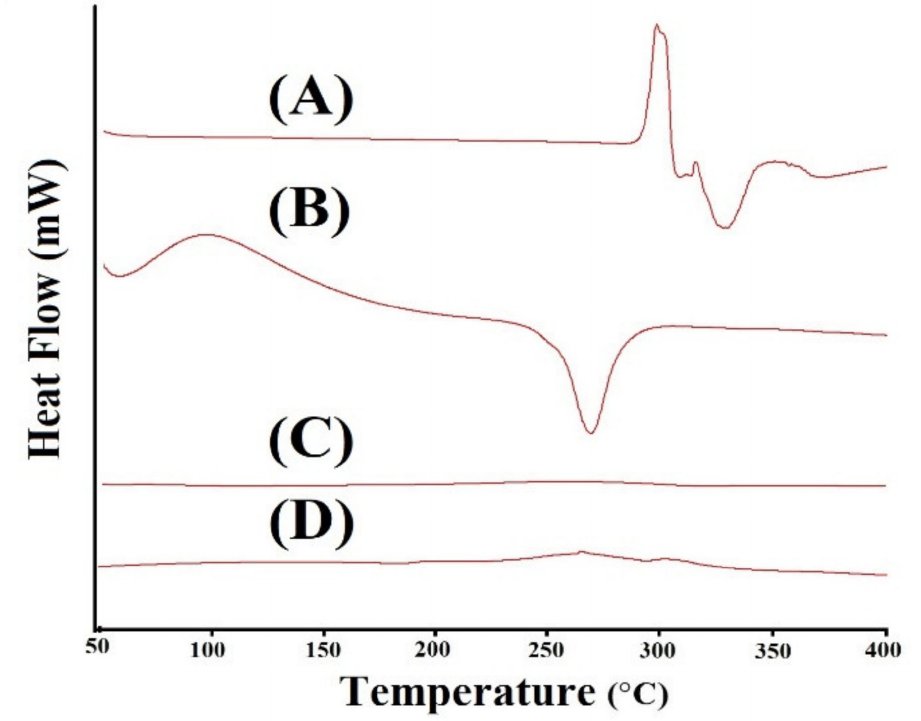
Figure 3. DSC (Differential scanning calorimetry) of ( A ) DS (Diclofenac sodium), ( B ) CS (Chondroitin sulfate), ( C ) CBP (Carbopol), and ( D ) CS/CBP-co-PAA